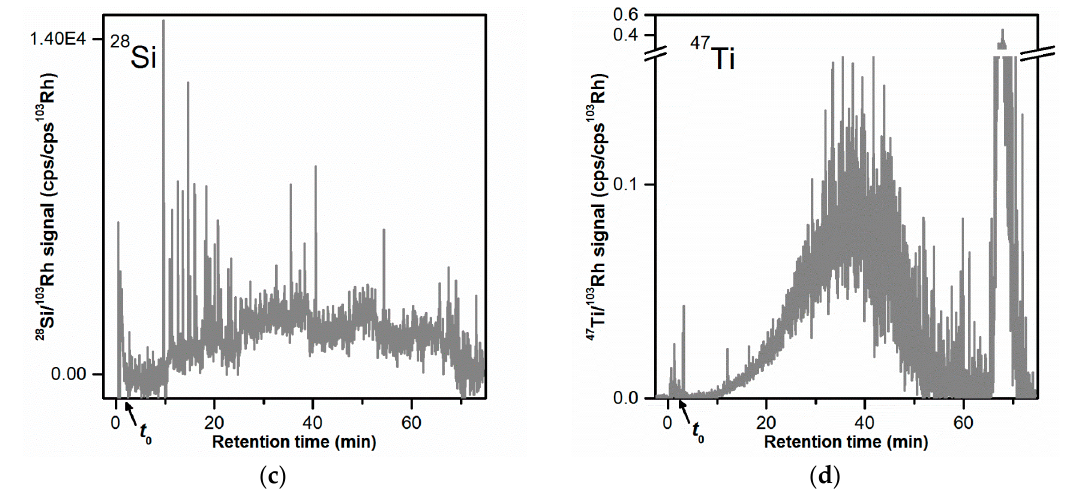
Figure 2. AF4 ‐ LS and AF4 ‐ ICP ‐ MS fractograms obtained for the toothpaste dispersion in 0.05% w/w SDS (10 μ g injected toothpaste mass). ( a ) AF4 ‐ LS fractogram based on the 90° LS signal. The rms diameters are shown as black circles. ( b ), ( c ), and ( d ) AF4 ‐ ICP ‐ MS fractograms based on the 27 Al, 28 Si, and 47 Ti signals (normalized to the internal standard 103 Rh), respectively. ( a ), ( b ), and ( d ) were obtained from the same AF4 separation. For ( c ), the sensitivity of the ICP ‐ MS instrument was reduced due to the high background signal at 28 Si. The 27 Al, 47 Ti fractograms obtained for that separation were reproducible but noisier. All AF4 separations were performed on the same membrane. The LS signal was smoothed.